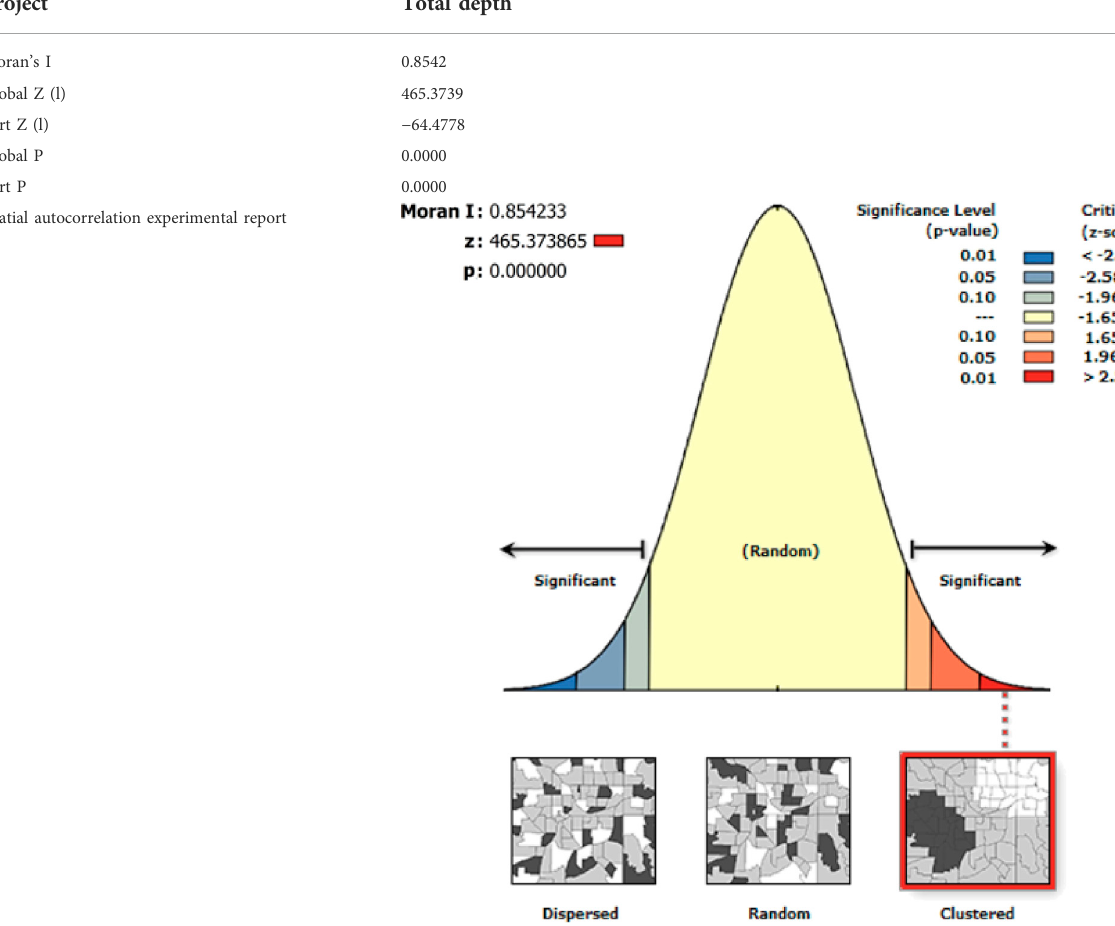
TABLE 2 Experimental data report of road network spatial autocorrelation in Harbin ’ s